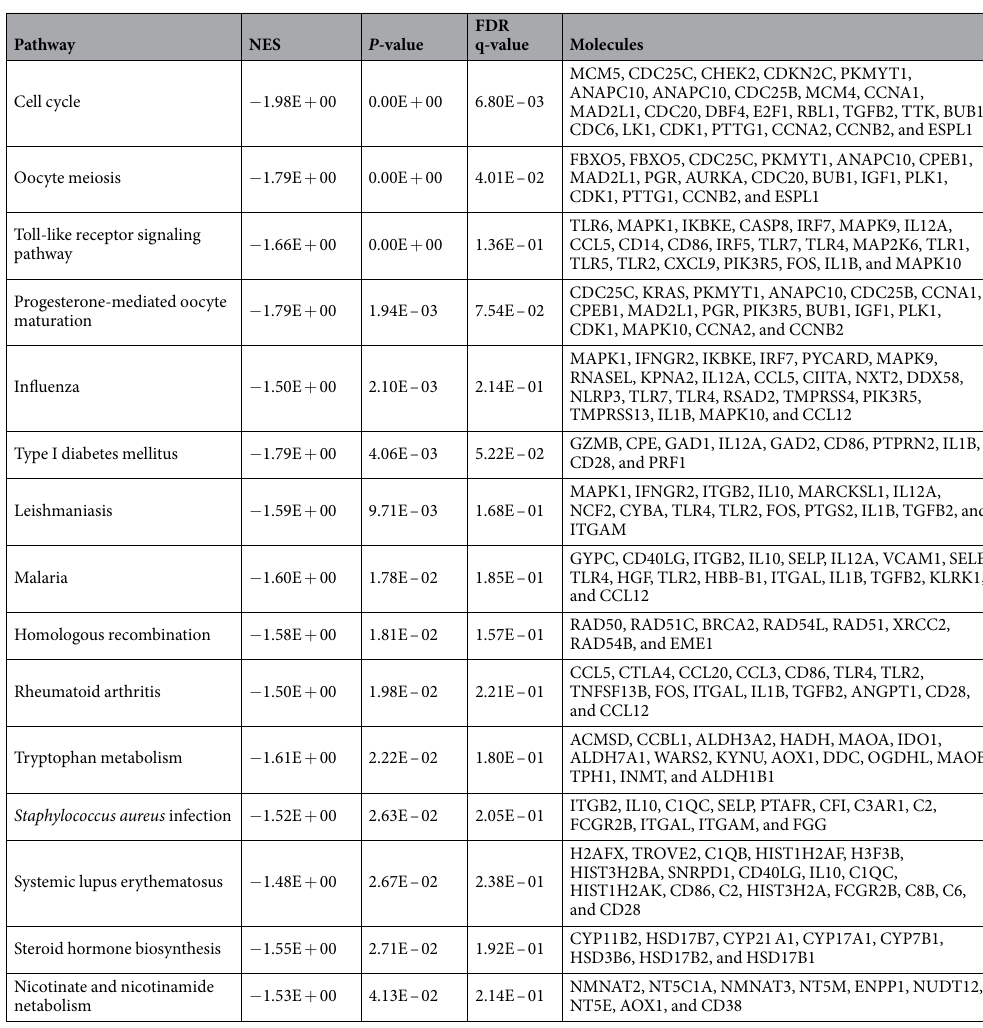
Table 3. Selected enriched pathways in normal control